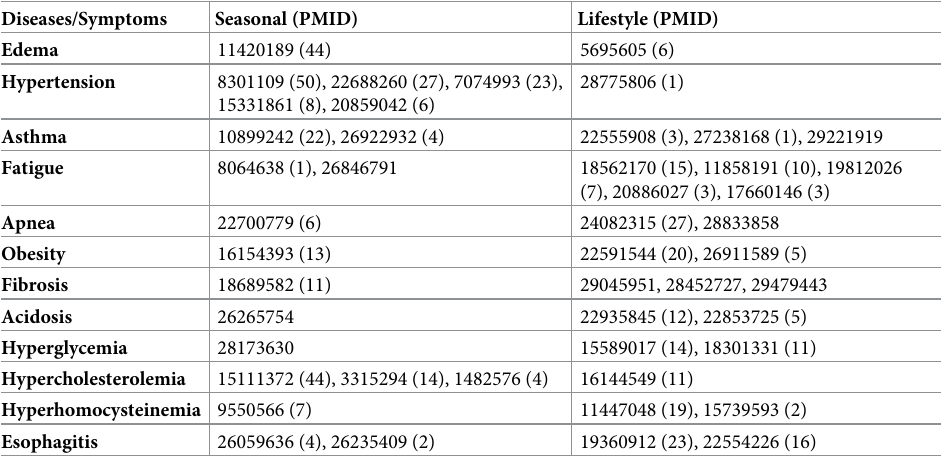
Table 5. List of clinical studies (PMIDs) reported the seasonal and life style factors impact on etiology of the core DSN. Please note that this list is not exhaustive and only includes some of the frequently cited reference PMIDs. The citation numbers of each PMIDs as on June 2018 from PubMed is given in the